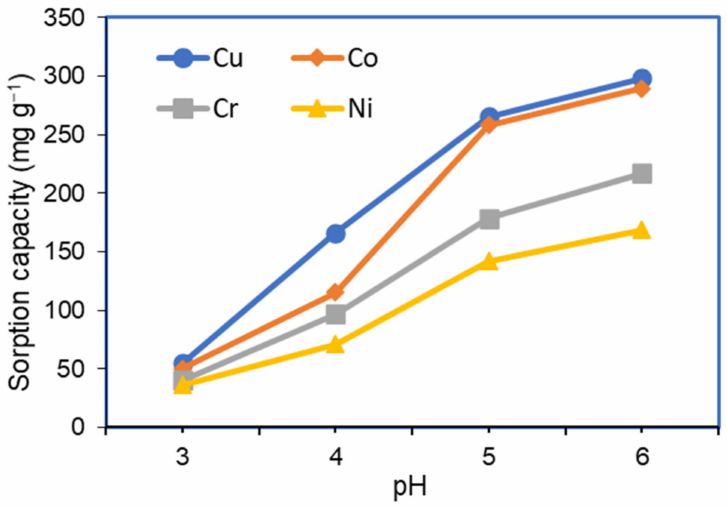
Figure 2. The effect of pH on the sorption behavior of heavy metals by poly(amidoxime) ligand. The sorption values of Co 2+ , Cr 3+ and Ni 2+ at pH 6 were 289.6, 217.0, and 168.7 mg g −